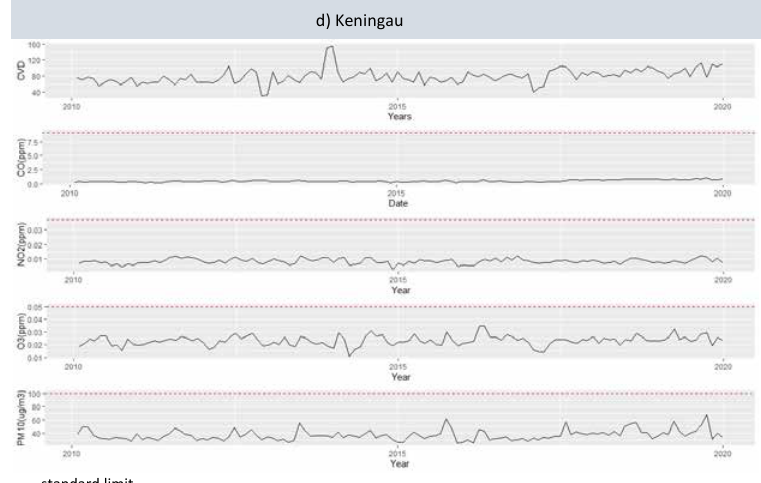
Fig. 1: Time series analysis of hospital admission for cardiovascular and air pollutants in Kota Kinabalu 2010– 2019